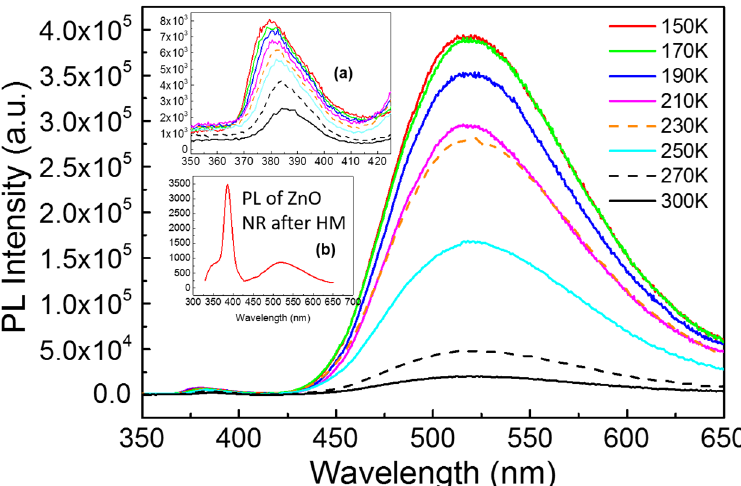
Figure 4. The temperature ‐ dependent photoluminescence (PL) spectra of ZnO NWs prepared by CVD combined with HM excited by 325 nm from 150 to 300 K. The inset ( a ) is the enlarged view at near ‐ band ‐ edge emission (NBE) while the inset ( b ) is the PL spectrum of ZnO NRs after HM at room